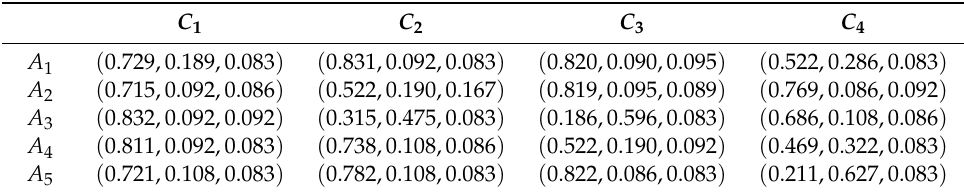
Table 4. The collective decision matrix is given by the q - RPFDWA